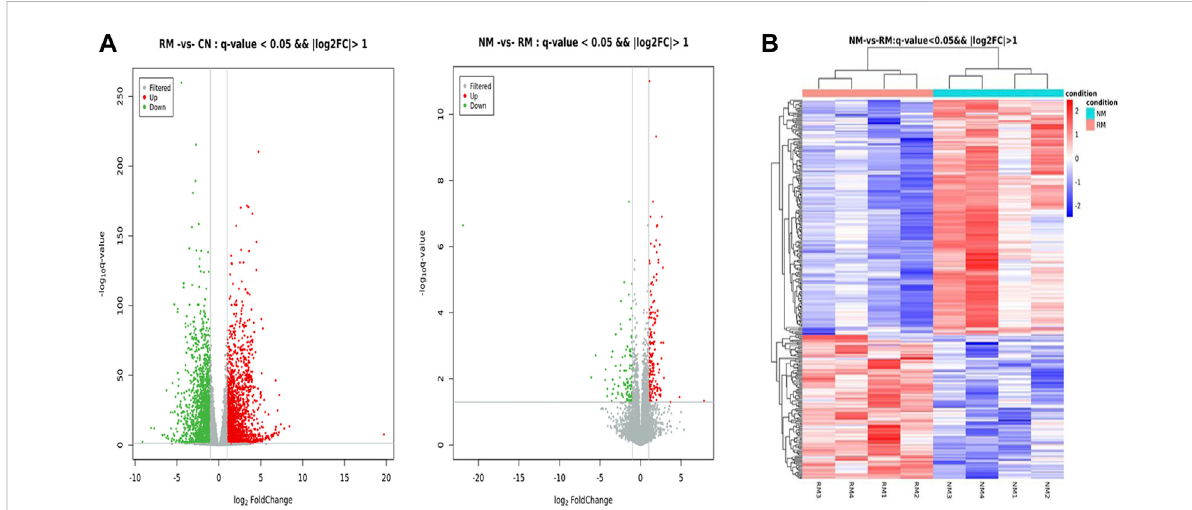
FIGURE 6 (A) Volcano plot of DEGs in RIAKI. The x and y axis represent log 2 (fold change) and p -value, respectively. Red and green dots represent corresponding upregulated and downregulated genes, respectively. (B) Heatmap of hierarchical clustering of DEGs between NM and RM. Color intensity is proportional to the abundance of gene expression. Red represents upregulated genes and blue represents downregulated